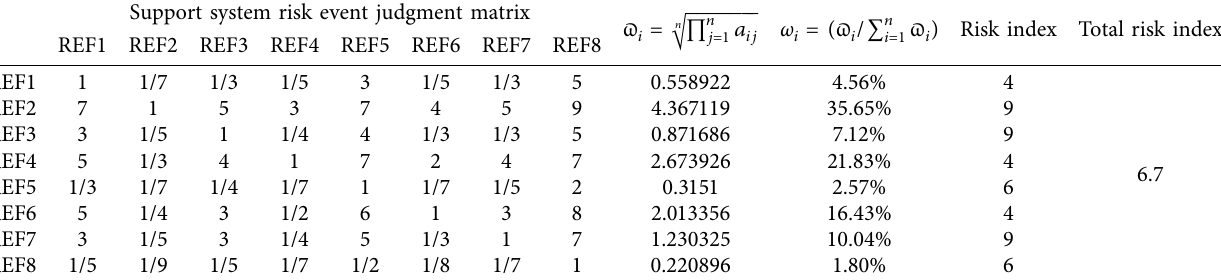
Table 24: Risk judgment matrix of support system.